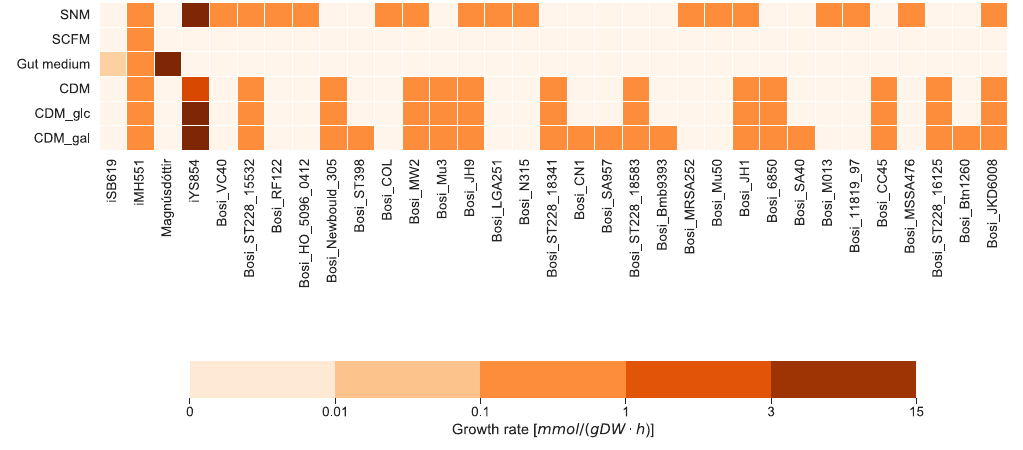
Fig. 4 Growth rate of S. aureus GEMs in different media. All models with initial growth (see Table 1) were tested on the different media. For the GEMs by Bosi et al. 32 , the pre fi x “ Bosi ” was added to the model strain name. The other models are named according to their published model ID or, in case of the model from the VMH database, by the author. Media types are the synthetic nasal medium (SNM), synthetic cystic fi brosis medium (SCFM), gut medium, chemically de fi ned medium (CDM), CDM with glucose (CDM_glc), and CDM with galactose (CDM_gal). Models that did not show growth in any of the tested media were excluded. The color-bar indicates the growth rate: the darker the color, the higher the growth rate of the model organism on the given